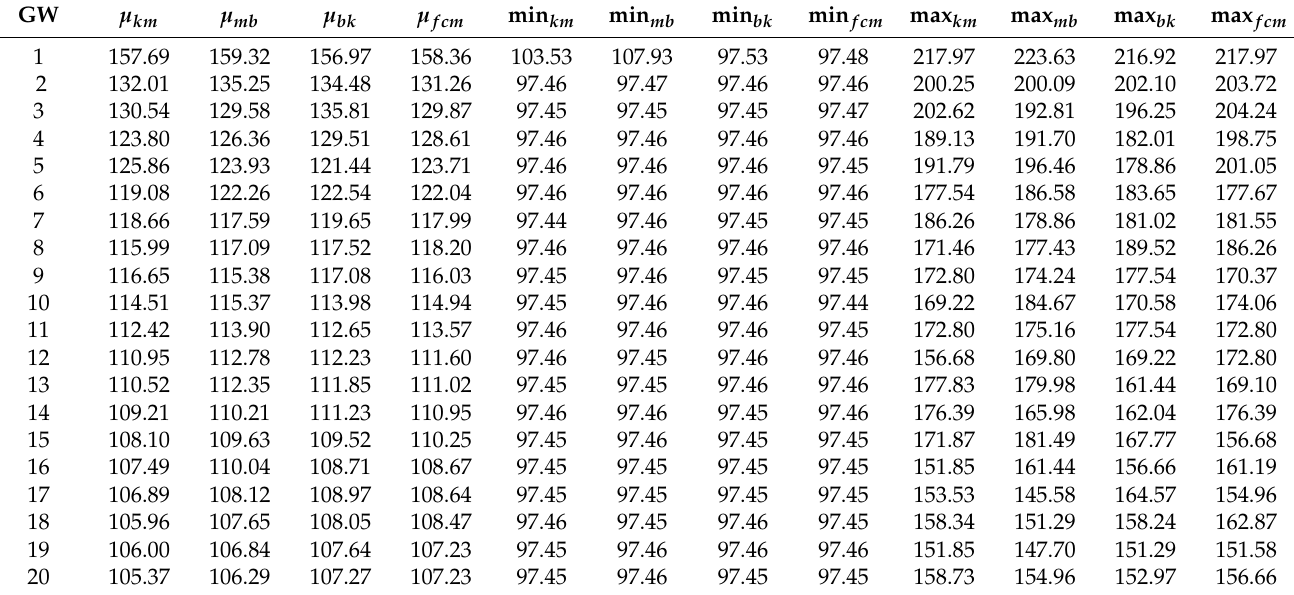
Table 6. Energy metrics for Scenario 2 by algorithm and number of GWs.